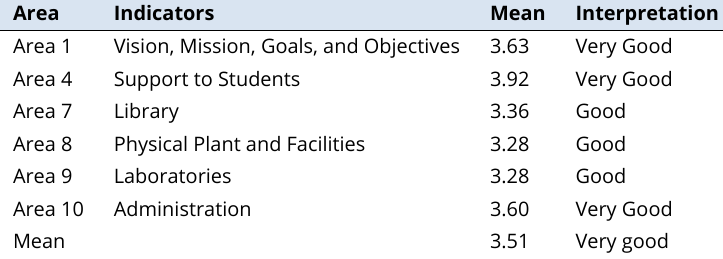
Common and General